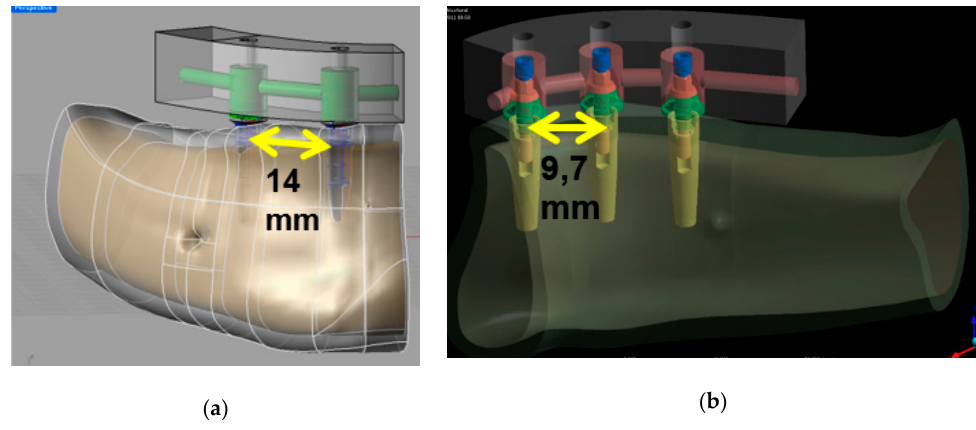
Figure 2. Assemblies employed in this study: ( a ) group M1; ( b ) group M2.